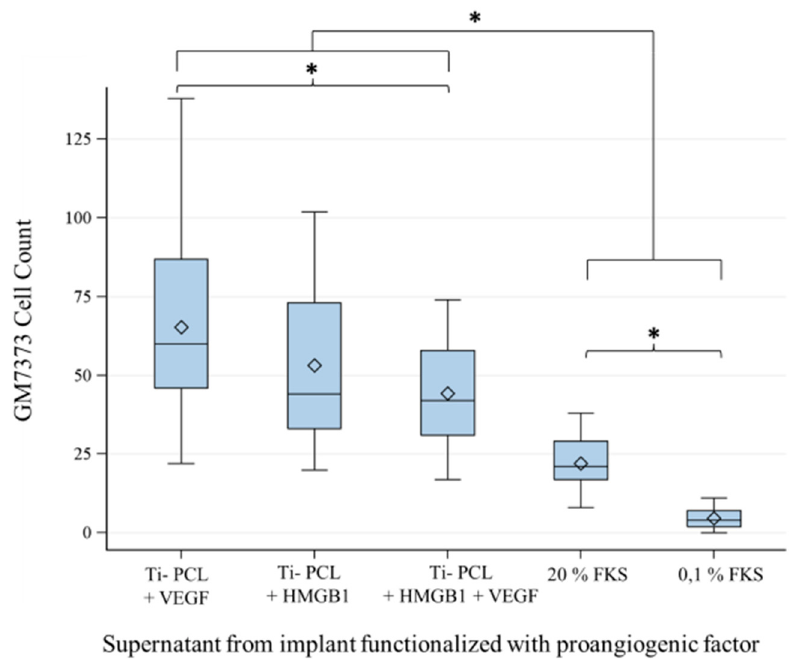
Figure 2. Migration Assay with GM7373 and supernatants from functionalized implants. Comparison of chemotactic behavior of the endothelial cell line (GM7373) using supernatants from implants functionalized with VEGF (vascular endothelial growth factor), HMGB1 (high mobility group box 1) and a combination of HMGB1/VEGF. All of the functionalized implants showed significantly higher chemotaxis than DMEM with 20% FCS or 0.1% FCS. VEGF was significantly more chemotactic than the combination of VEGF + HMGB1. F -test from the analyses of variance followed by pairwise multiple means comparisons with the Least Significant Difference test were used ( p ≤ 0.05).